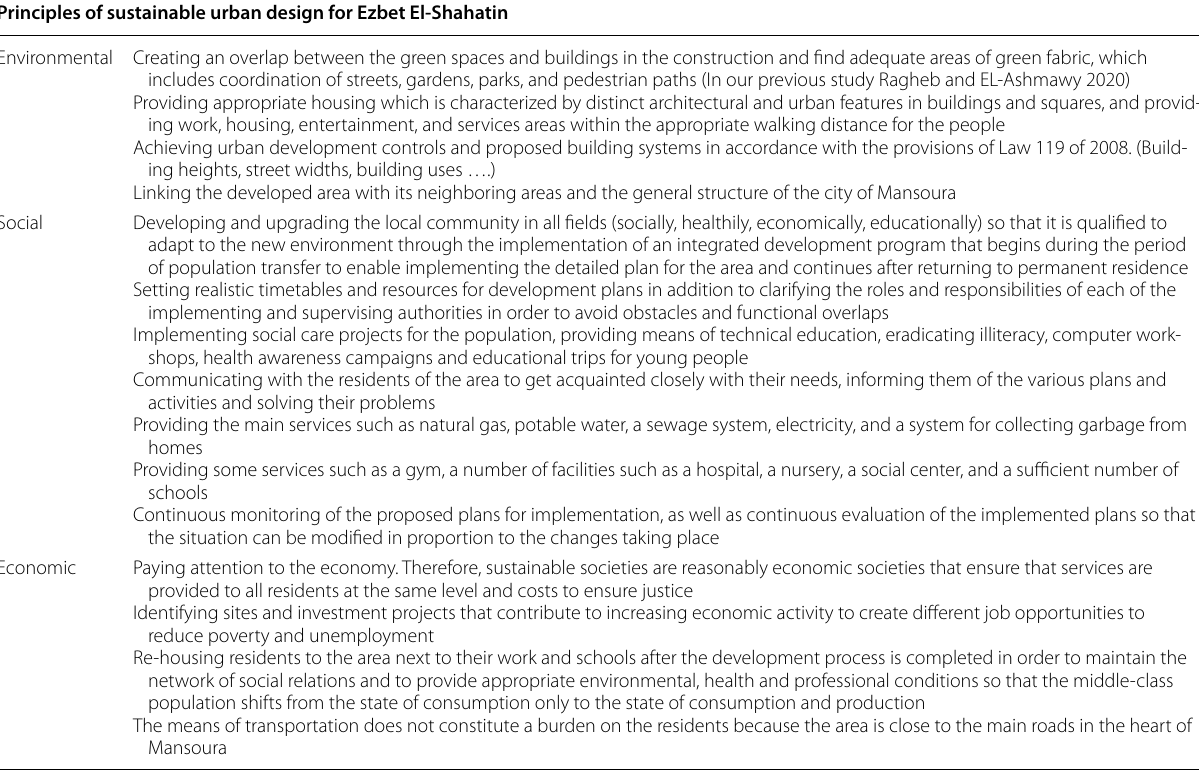
Table 7 Principles of sustainable urban design for Ezbet El‑Shahatin Principles of sustainable urban design for Ezbet